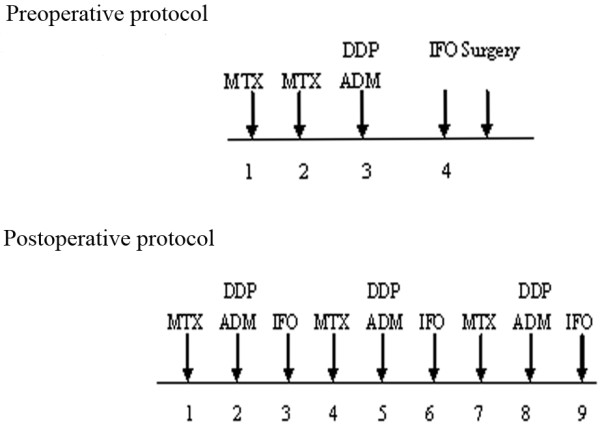
The chemotherapeutic agents and the treatment protocol of 177 osteosarcoma patients.